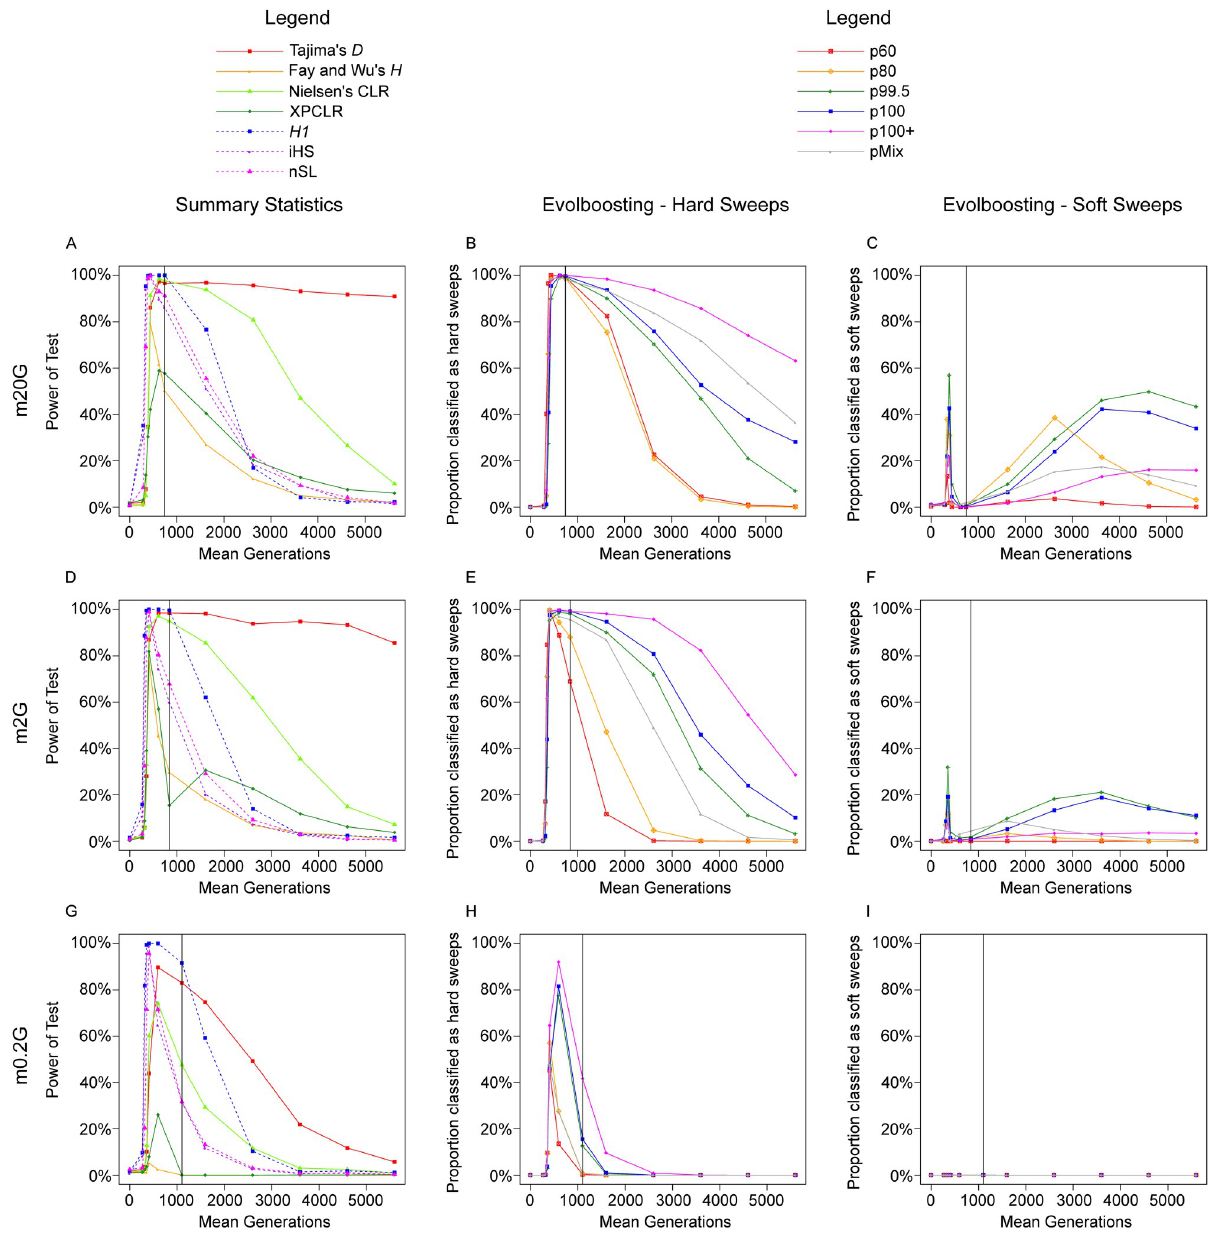
Fig 6. Full-locus simulation: The detection rate of various methods in global adaptation scenarios in the native deme. The proportion of samples detected as selective sweeps by various methods, under the scenarios: A-C. m 20 G , D-F. m 2 G , G-I. m 0.2 G , in d 1 where the adaptive allele arises. The vertical line indicates time of 100% fixation. A,D,G. Power of seven summary statistics; dashed lines indicate haplotype-based methods. B,E,H. Proportion detected by six EvolBoosting predictors correctly as hard sweeps. C,F,I. Proportion detected by six EvolBoosting predictors incorrectly as soft sweeps. See S3 Fig for a zoomed-in version for early stages of m 0.2 G